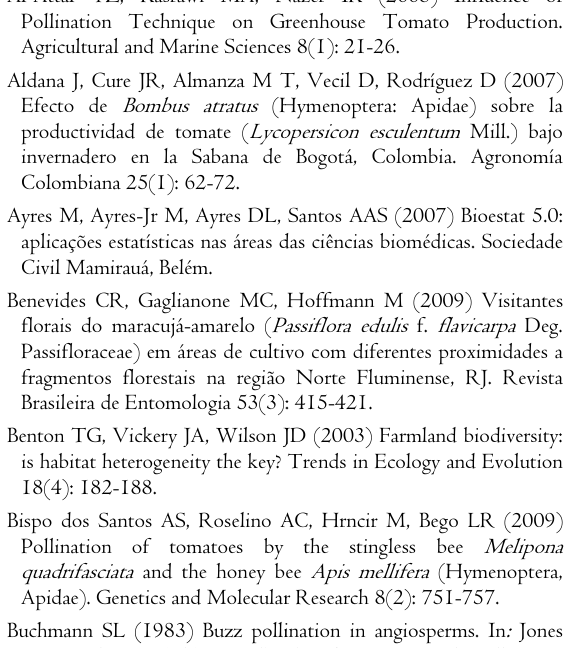
F IGURE 4. (A) Widest circumference (cm) and (B seeds of tomato fruits (mean ± SD) from the pollination tests performed in the greenhouse. Spontaneous self- supplemental manual cross pollination (SCP), manual cross pollination in the same cultivar (CSC) and manual cro between cultivars (CBC). Different letters indicate different means according to the Kruskal-Wallis Test ( P <